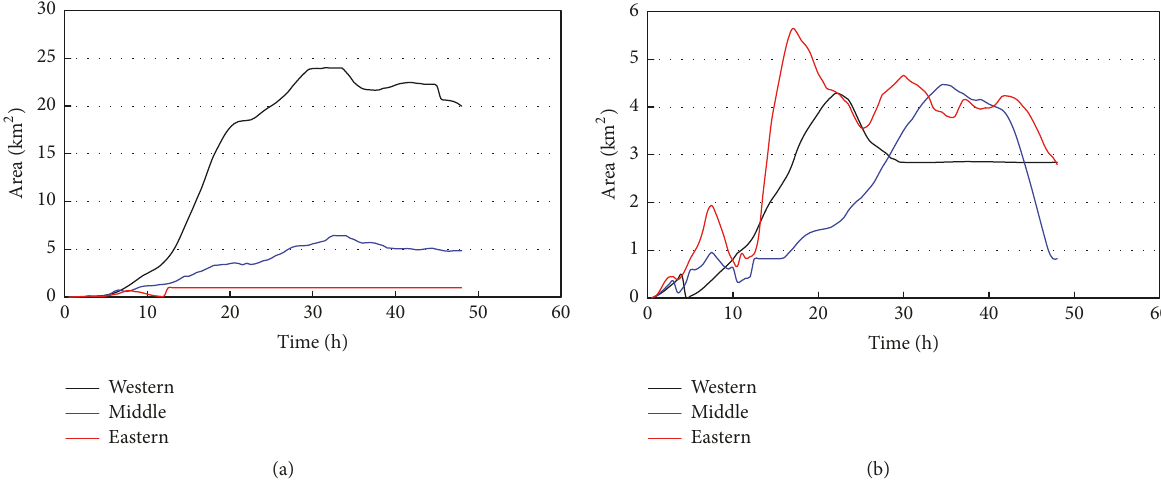
Figure 24: Area of instantaneous (a) and continuous (b) oil spills versus time in different spill locations (black line for the western spill location, blue line for the middle spill location, and red line for the eastern spill location) under the influence of northeast